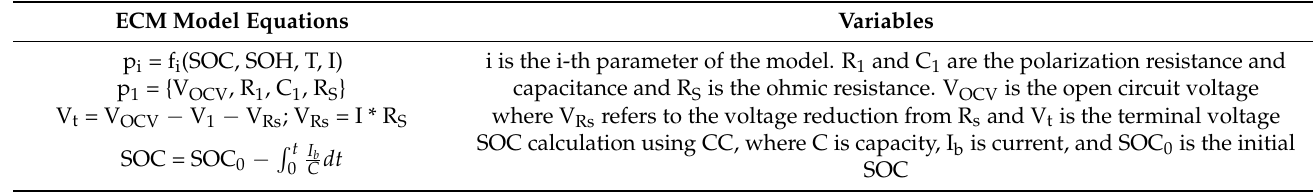
Table A2. Equations of ECM model in the time domain for pulse current [72]. ECM Model Equations